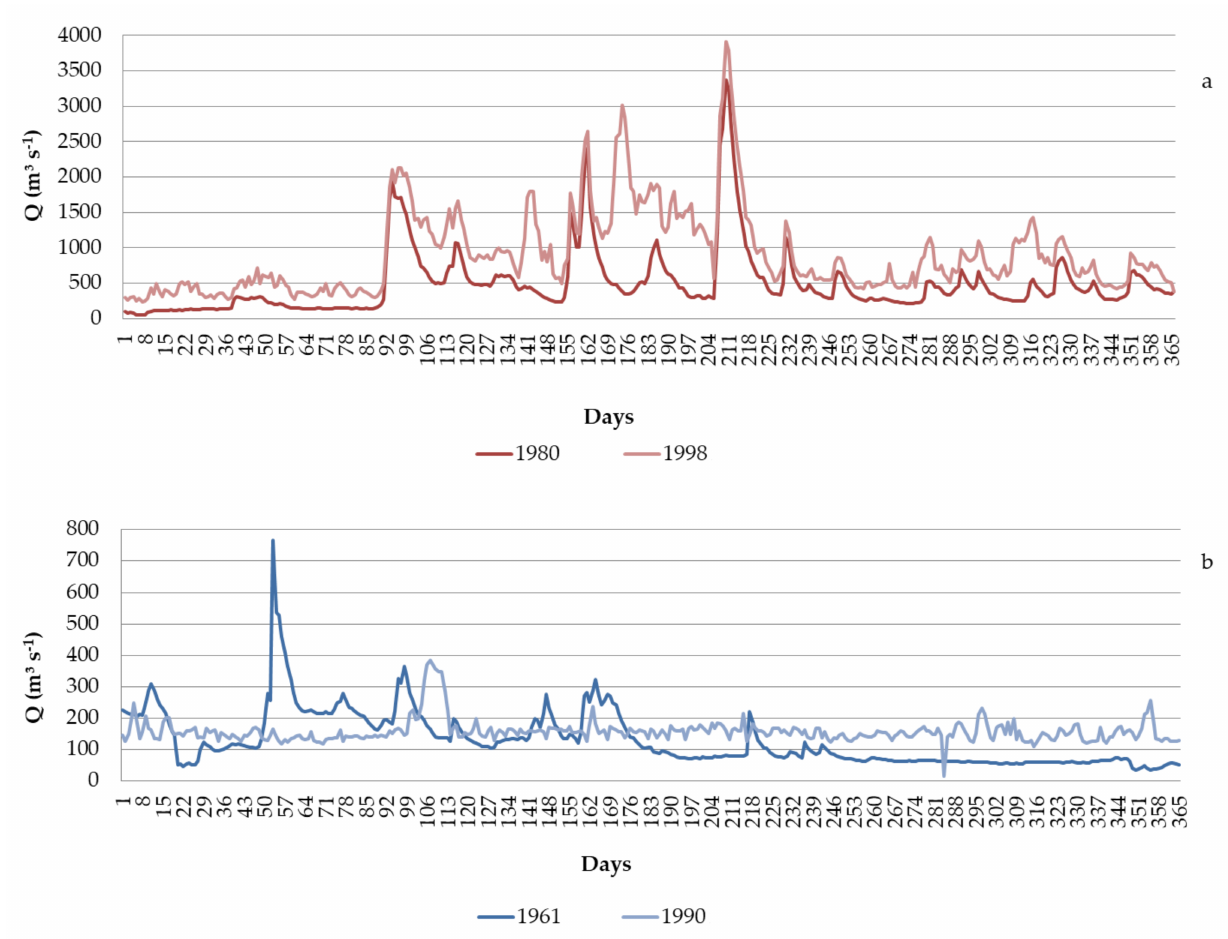
Figure 10. The annual hydrographs of water discharges at Mohyliv-Podilskyi HGS. ( a ) “Before and after” years with the maximum annual runoff (1980 and 1998) and ( b ) “before and after” years with the minimum annual runoff (1961 and 1990).